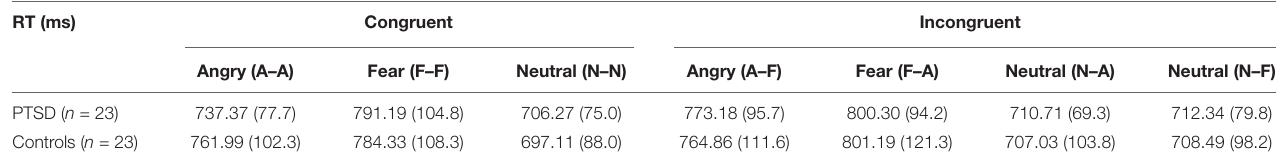
TABLE 3 | Mean reaction times (and SDs) for congruent and incongruent targets for PTSD patients and military controls. RT (ms)